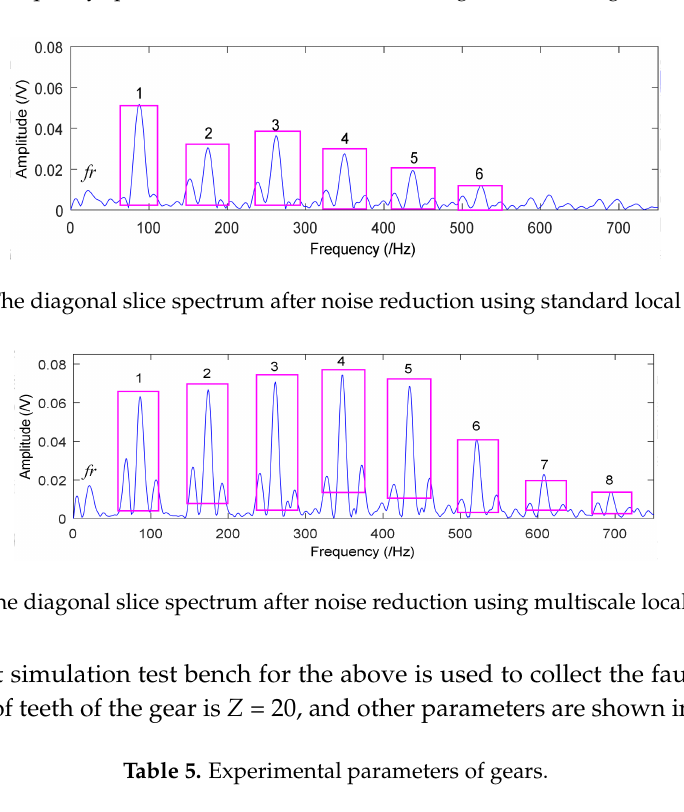
Figure 26. The frequency spectrum after noise reduction using smooth orthogonal decomposition.